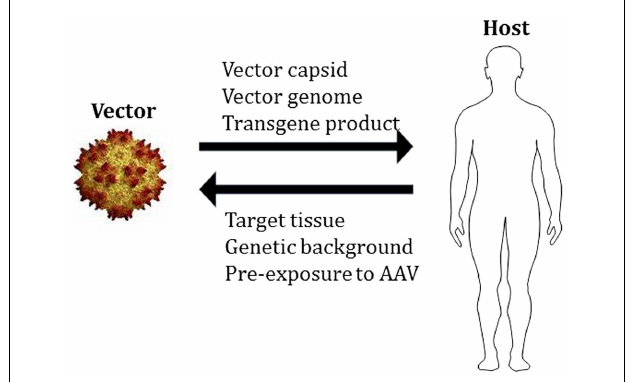
FIGURE 1 |Adeno-associated virus vector:host interactions .The components of AAV vectors interact with the host in determining the outcome of gene transfer. For the AAV vector, the total capsid dose, the genome (single-stranded vs. self-complementary, CpG content, etc.), and the transgene product (to which the host may not be tolerant), represent some of the elements that could contribute to vector immunogenicity. On the host side, the characteristics of the target tissue (immunoprivilege, presence of inflammation, tolerogenic properties, etc.), the genetic background of the host (underlying disease-causing mutation, HLA haplotype, etc.), and the pre-exposure to the wild-type virus, can contribute to shape the overall response to vector